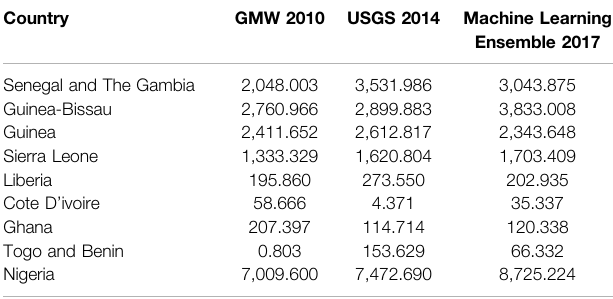
TABLE 1 | Comparison for the total mangrove areas (km 2 ) calculated from our 2017 data product, USGS 2014 data product, and GMW 2010 data product. Country